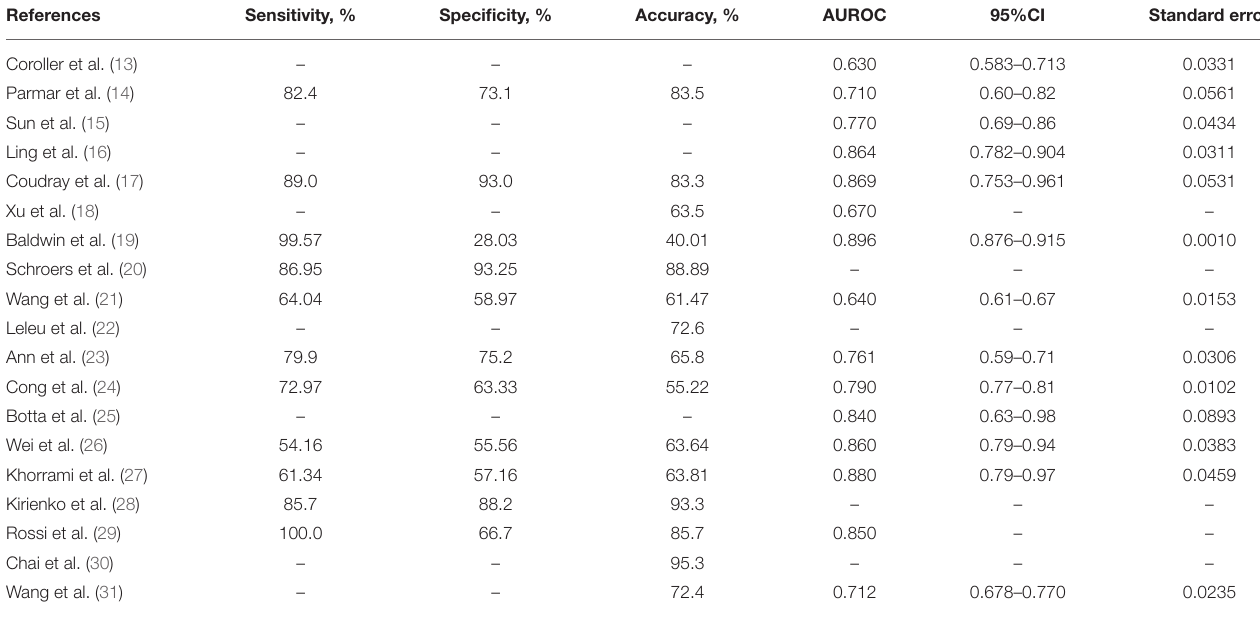
TABLE 5 | Summary of AUROC for each